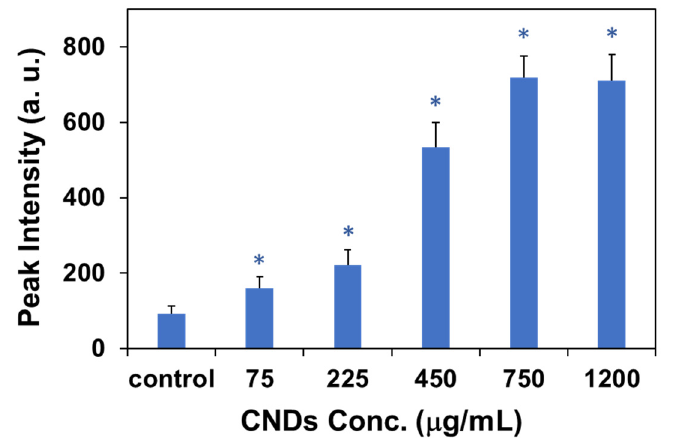
Figure 7. Light intensity of nucleus region of cells with 24 h CND incubation as a function of concentration for incubation. The error bars represent standard deviation. * Stands for a significant difference from the control (0 mg/mL) ( p < 0.05).